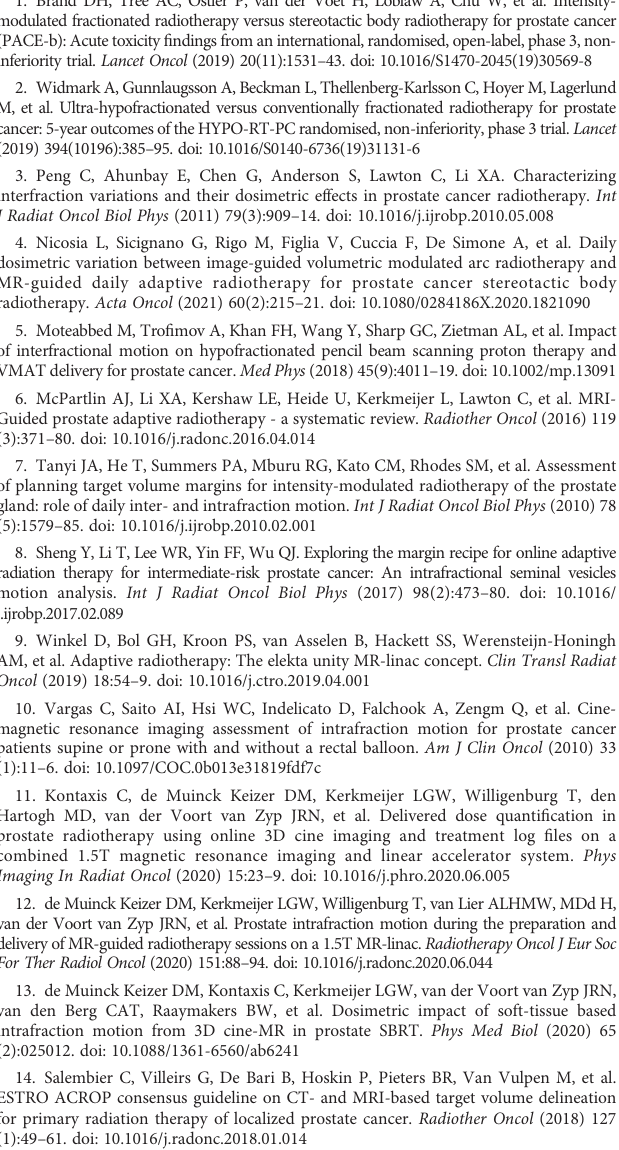
SUPPLEMENTARY FIGURE 2 Per-patient SVs-V 100% (A) and SVs-V 95% (B) mean values to the clinical target volume (CTV) summed by fi ve fractions of pre- (ATS plan), PV-, Bn- and post- MR scans. Scar bars present the standard deviation (SD). No beam-on scans were acquired for the fi rst 7 patients due to concerns about unexpected target and OAR moving. No SVs irradiation for Patient. #6, #7, #15 to